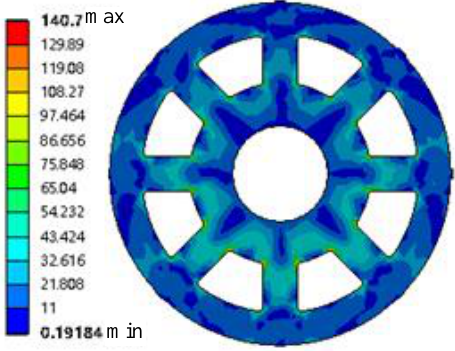
Figure 14. Stress distribution diagram of the rotor under the rated condition.